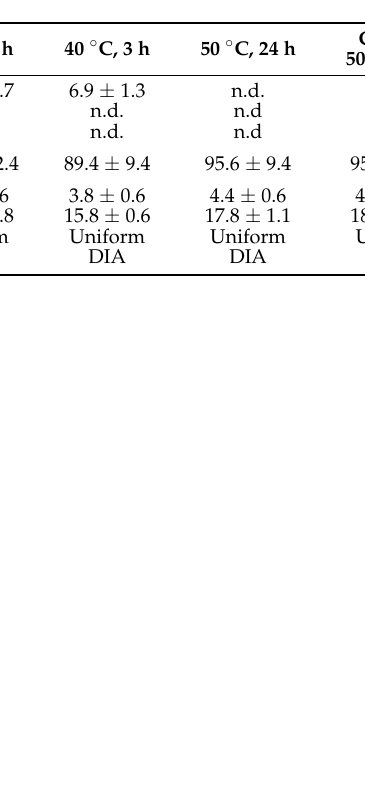
Figure 2. The XRD patterns of pure E2 and the prepared patches. The placebo patch was prepared without DMSO and E2 (consisting of DT), and the control patch was prepared without DMSO (consisting of E2 + DT).